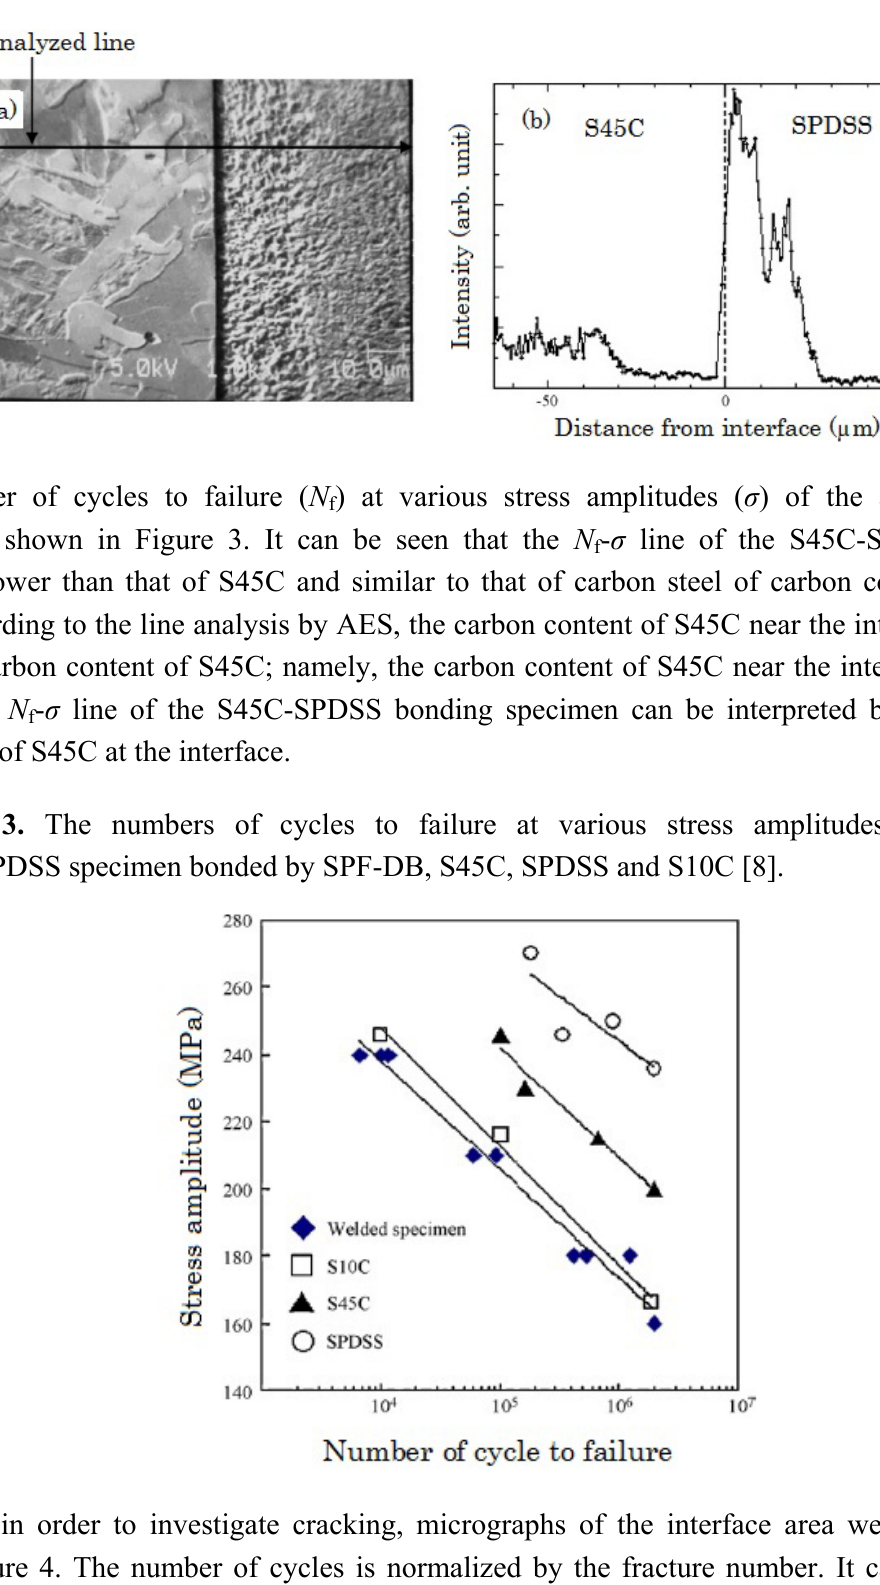
Figure 2 . Cross-sectional view of the interface between S45C and SPDSS bonded by the SPF-DB method: ( a ) shows scanning electron micrograph; and ( b ) line analysis by Auger electron spectroscopy for carbon [8].